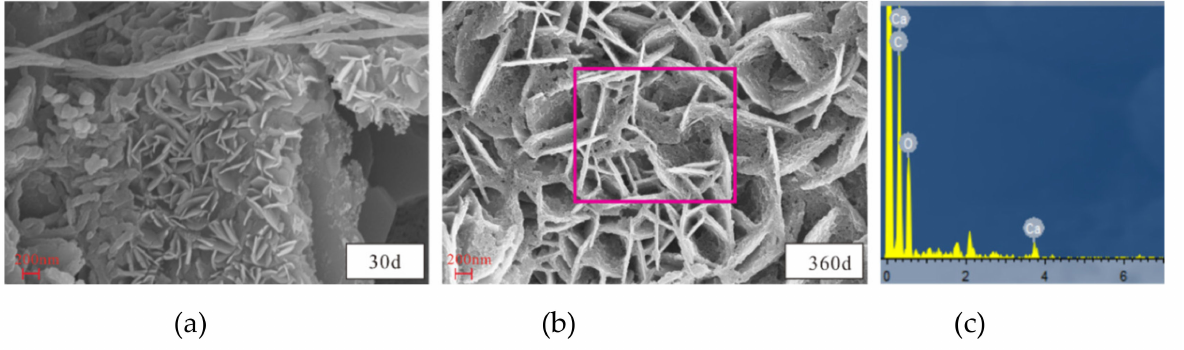
Figure 11. Picture of Ca (OH) 2 microstructure and EDS in CS3 solution: ( a ) 30d, ( b ) 360d, ( c )